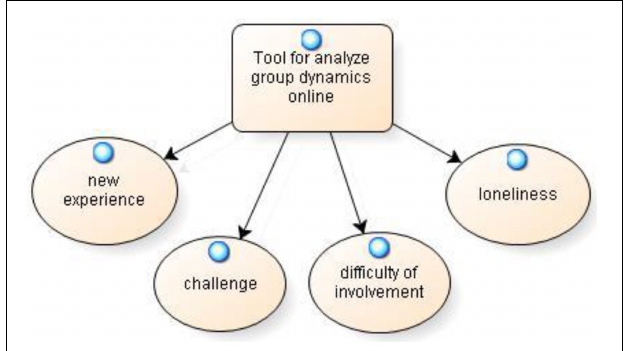
FIGURE 4 | Tool for analyze group dynamics